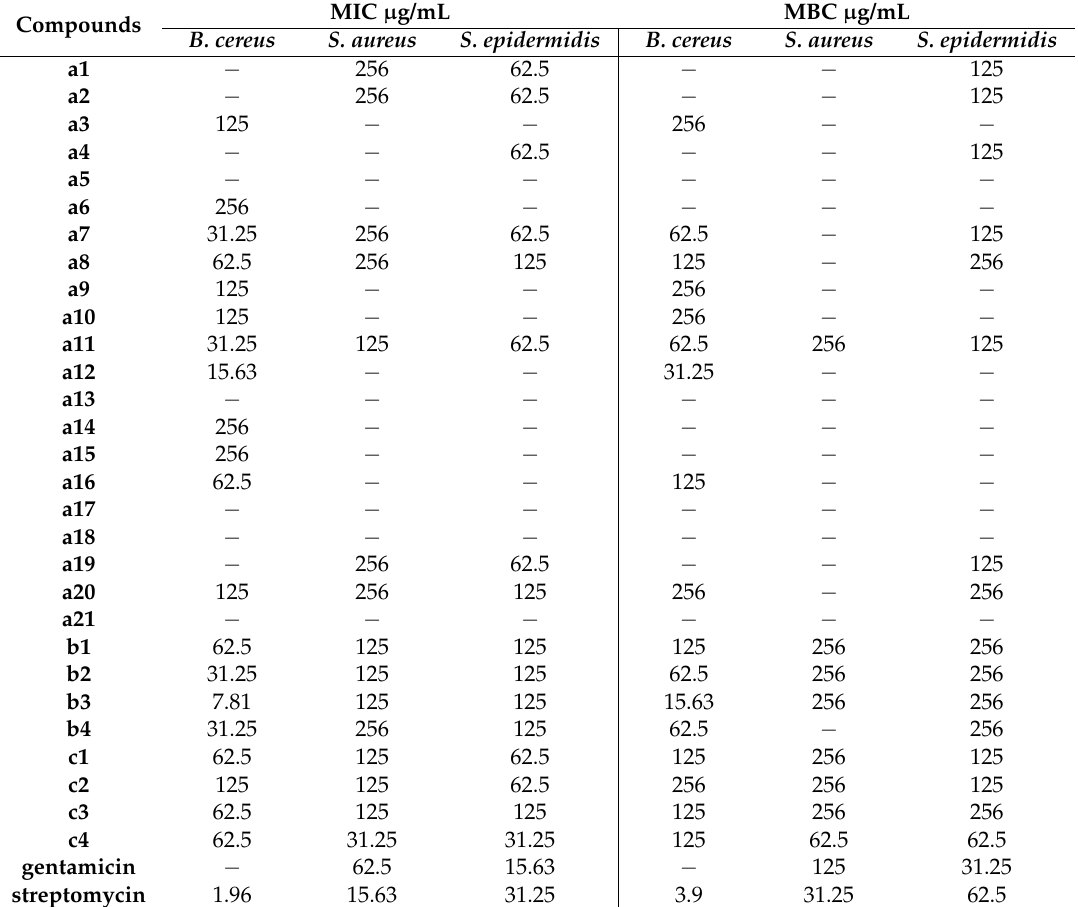
Table 1. Antibacterial activity of calycanthaceous alkaloids derivatives against B. cereus , S. aureus , and S. epidermidis